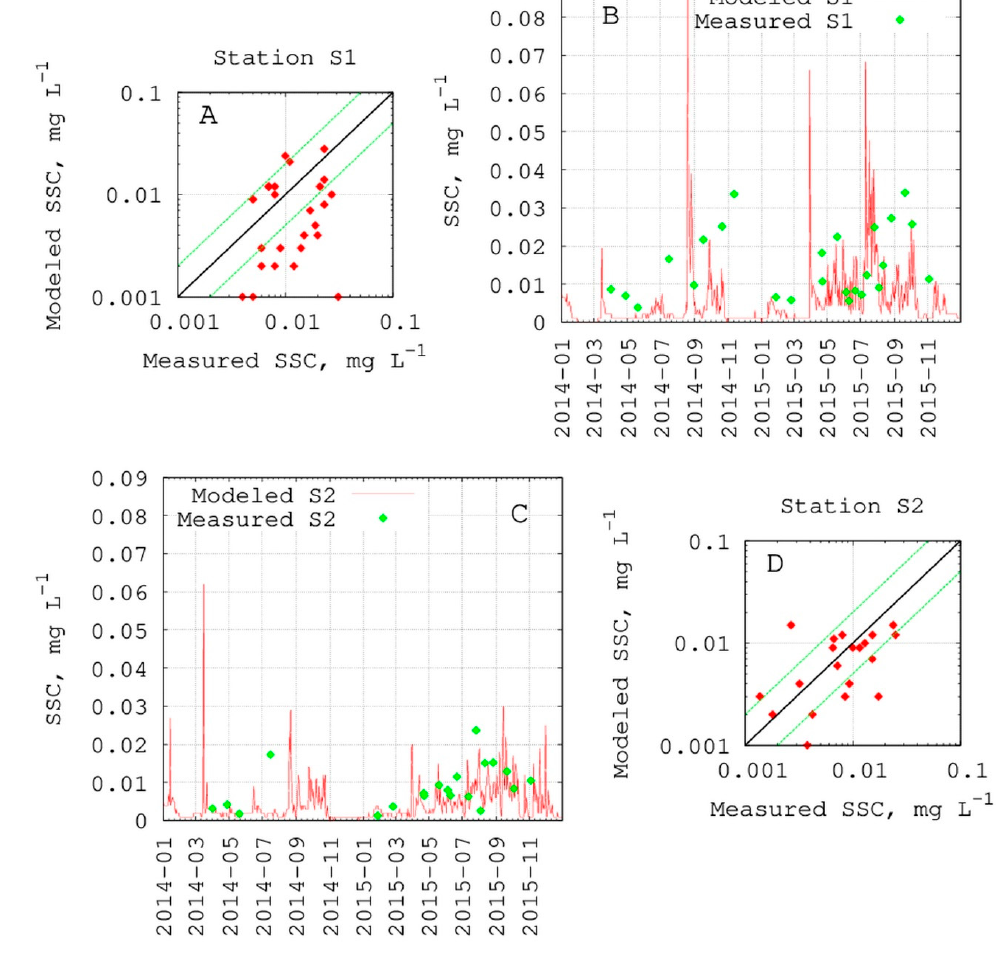
Figure 6. Comparison of the predicted and observed values after sediment model calibration for station S2 ( A , B ) and S1 ( C , D ). Scatterplots ( B , D ) are made using a logarithmic scale, where the solid line indicates absolute agreement with the measurements; the green lines correspond to the endpoints of double relative discrepancy intervals.